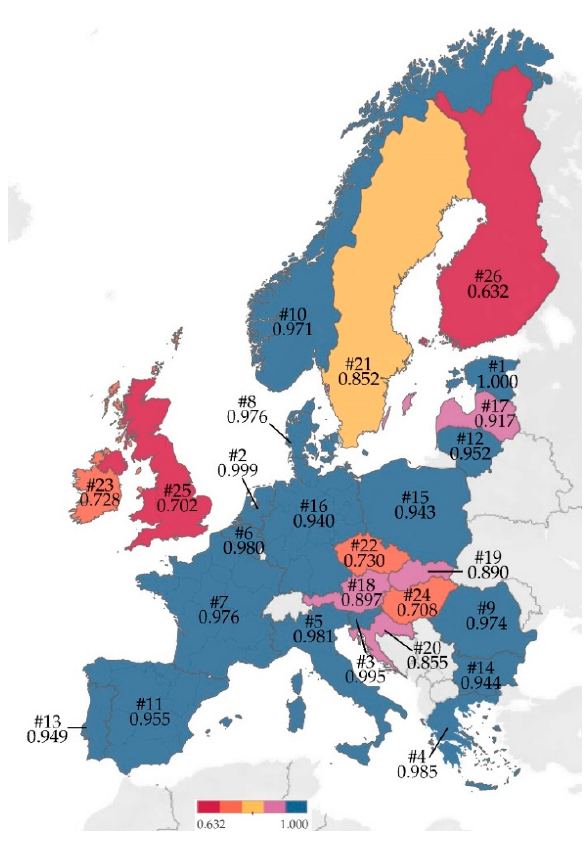
Figure 9. Efficiency scores map, Window Width (9)